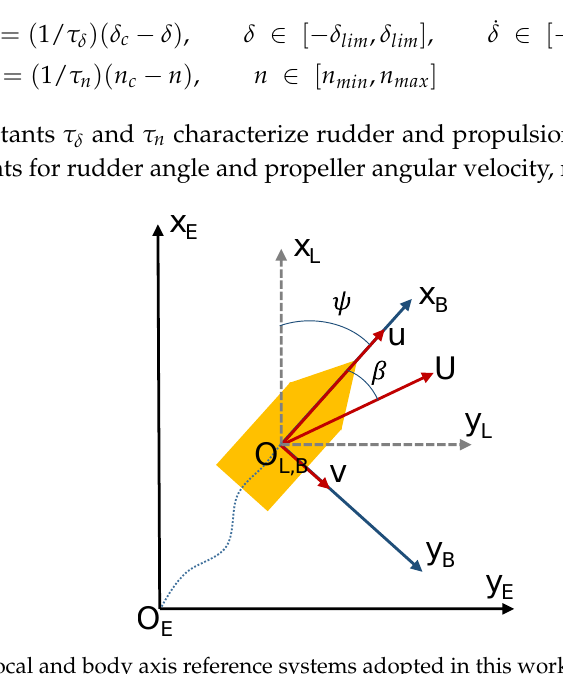
Figure 2. Earth, local and body axis reference systems adopted in this work, where β is the slip